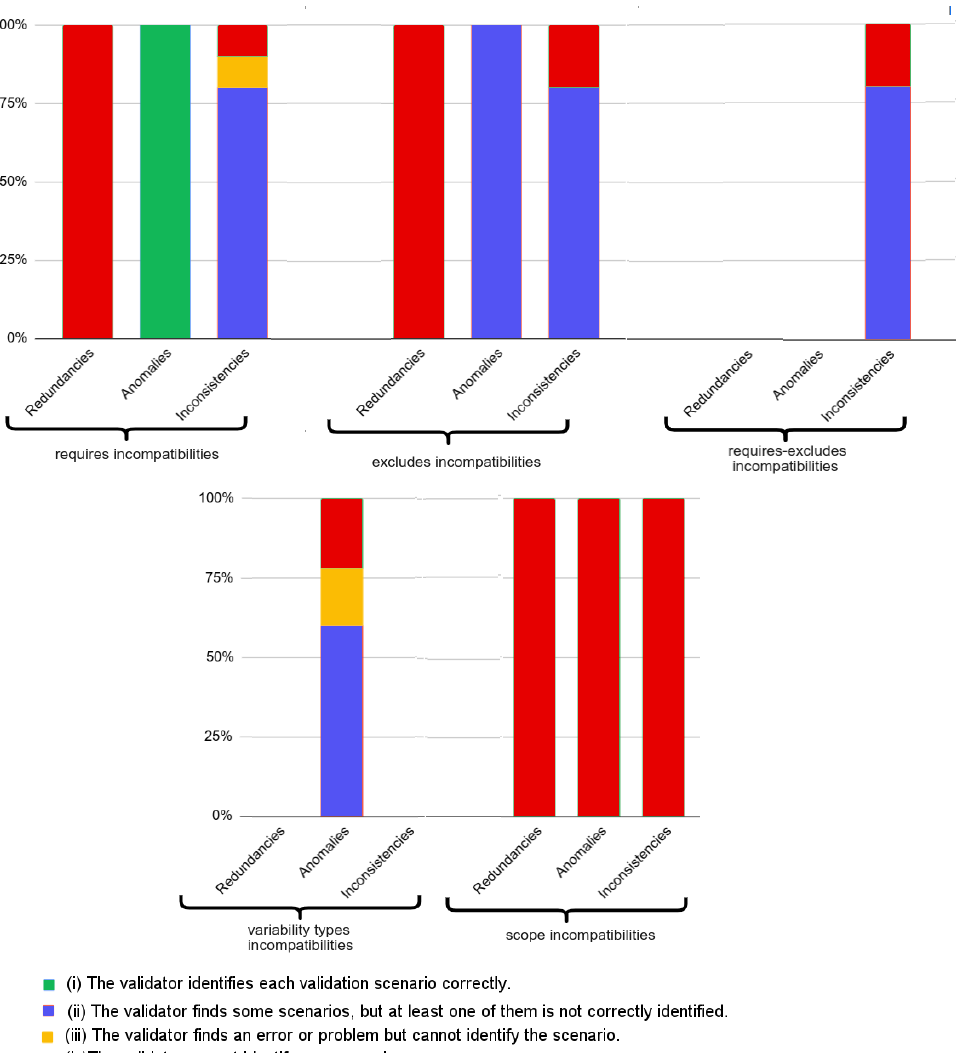
Figure 18. Results obtained by the basic SAT solver